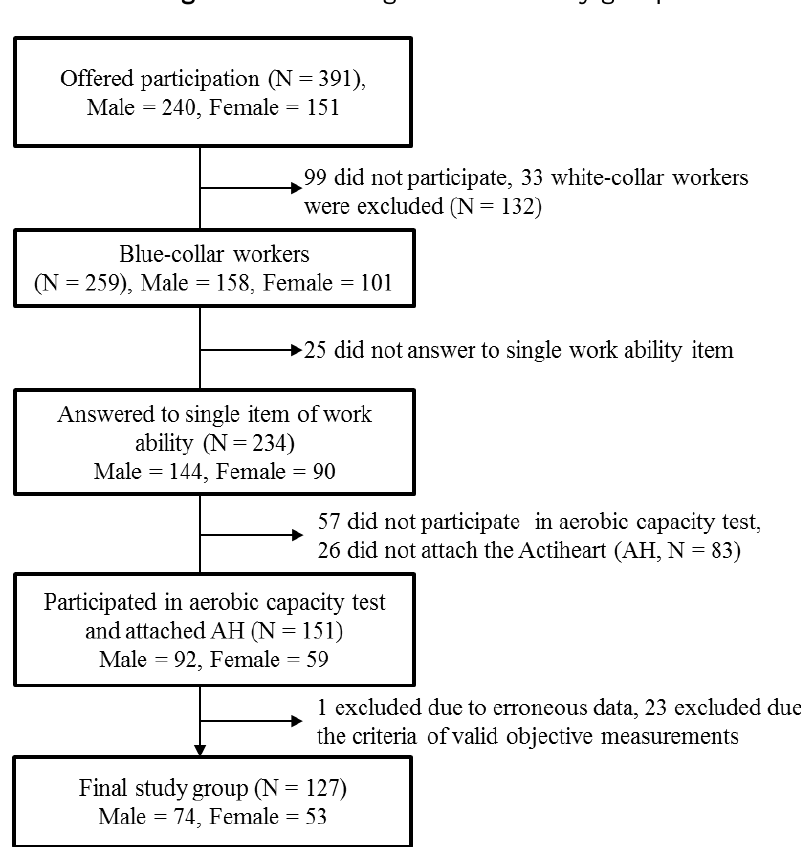
Figure 1. Flow diagram of the study group.